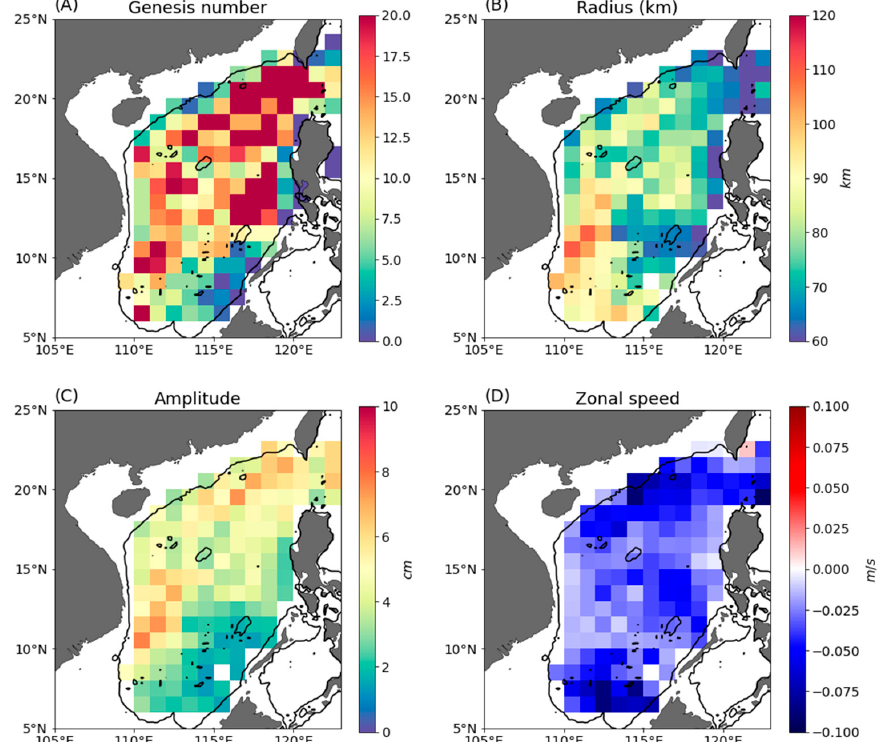
Figure 3. Geographic distributions of the eddy ( A ) genesis number, ( B ) radius, ( C ) amplitude, and ( D ) zonal propagation speed on a 1° × 1° longitude–latitude grid in the SCS from January 1993 to 2015. The black contour in each panel denotes the 200 m isobath.